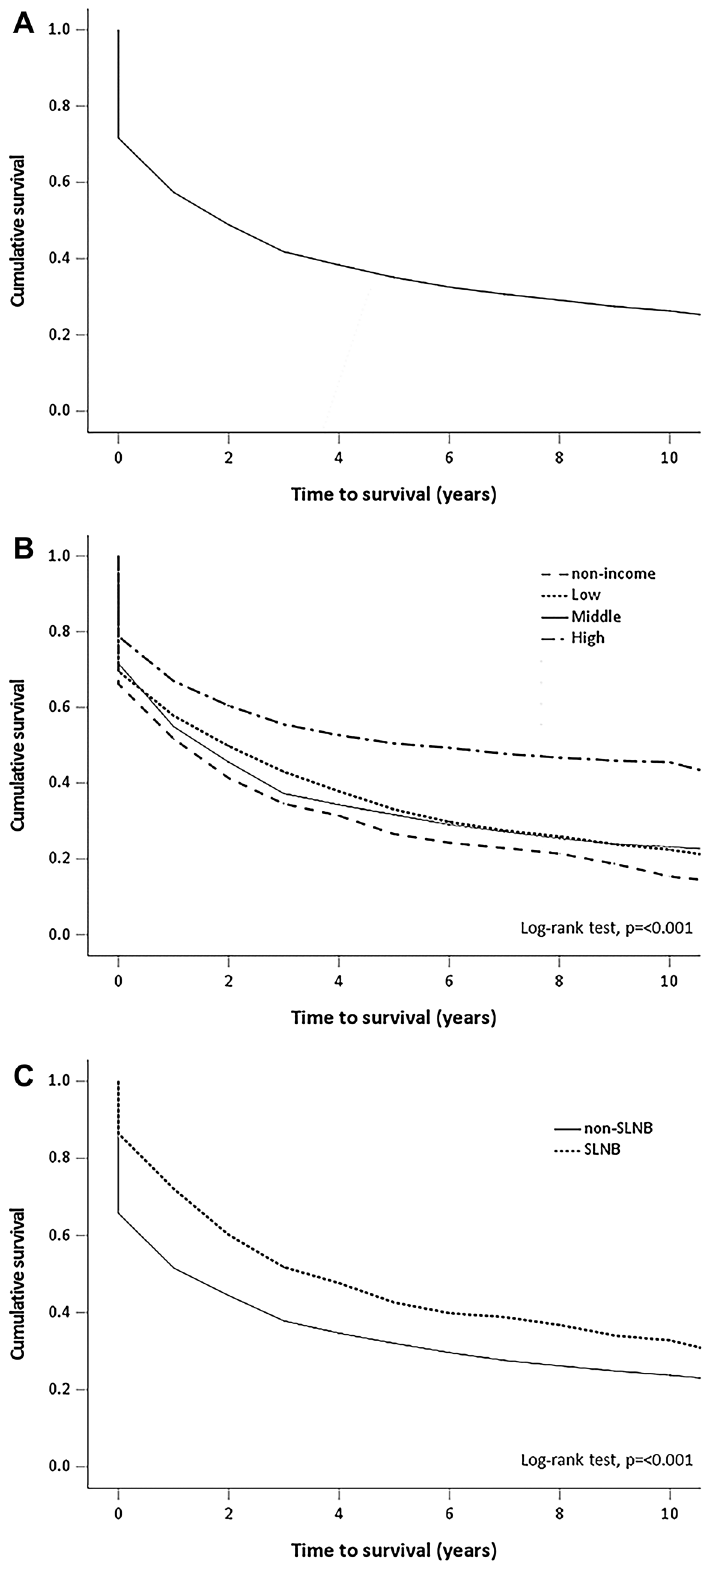
Figure 2. Overall survival of patients with malignant melanoma in Taiwan. ( A ) Cumulative proportion of the 3284 patients expected to survive. ( B ) Patients in different categories of social economic status. ( C ) Patients undergoing sentinel lymph node biopsy or